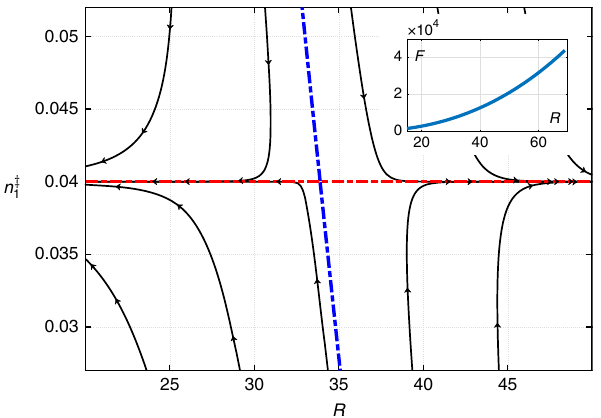
of the 1 for all values of R . The 1